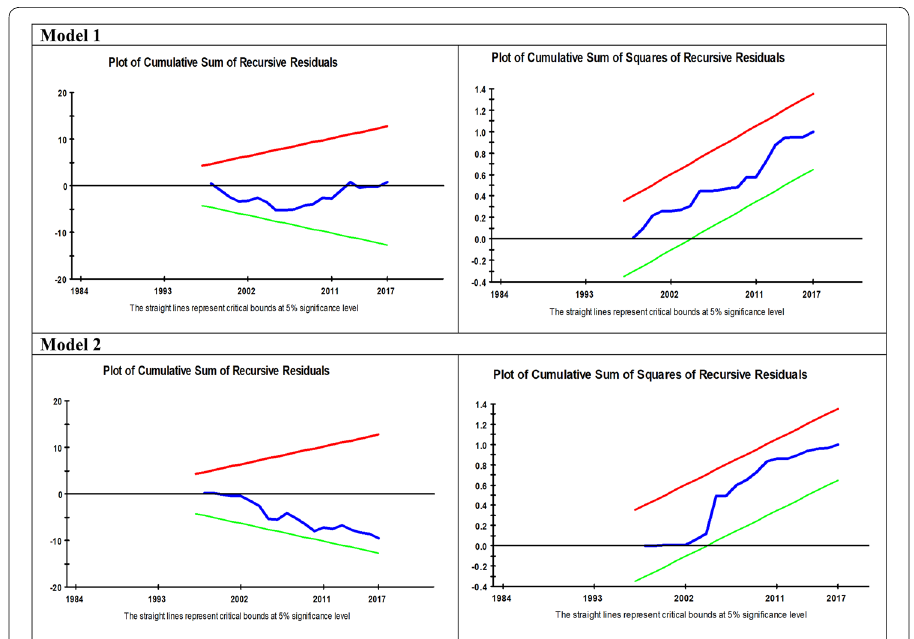
Fig. 1 CUSUM and CUSUMQ Results for Models 1 and